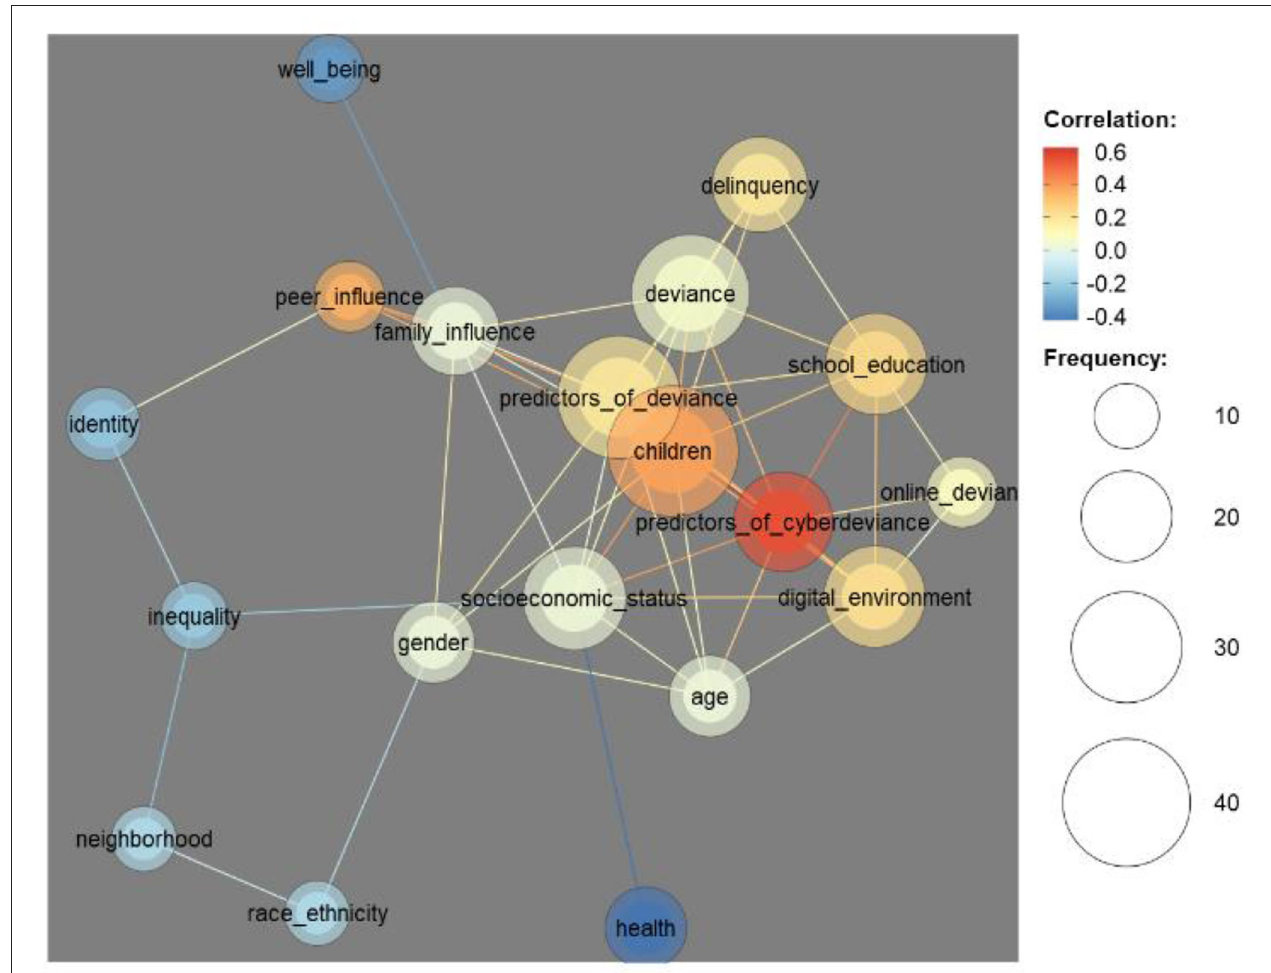
FIGURE 5 | Co-occurrence network of the most encountered codes as applied to